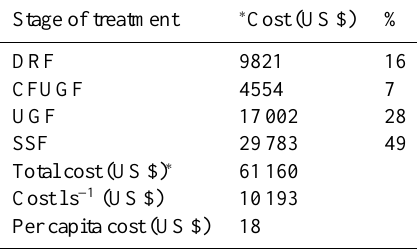
Table 9. Initial investment costs. Table 10. Operation and maintenance